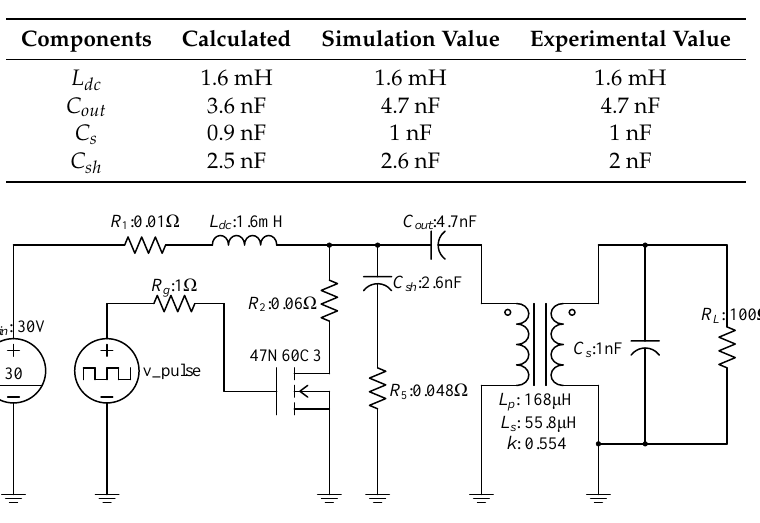
Table 3. Critical parameters of the charger.